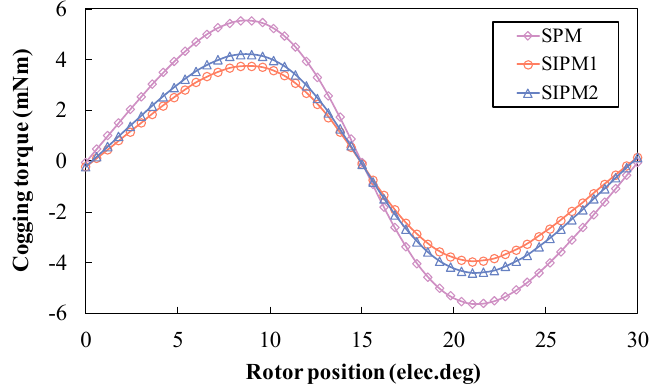
Figure 10. Cogging torque.